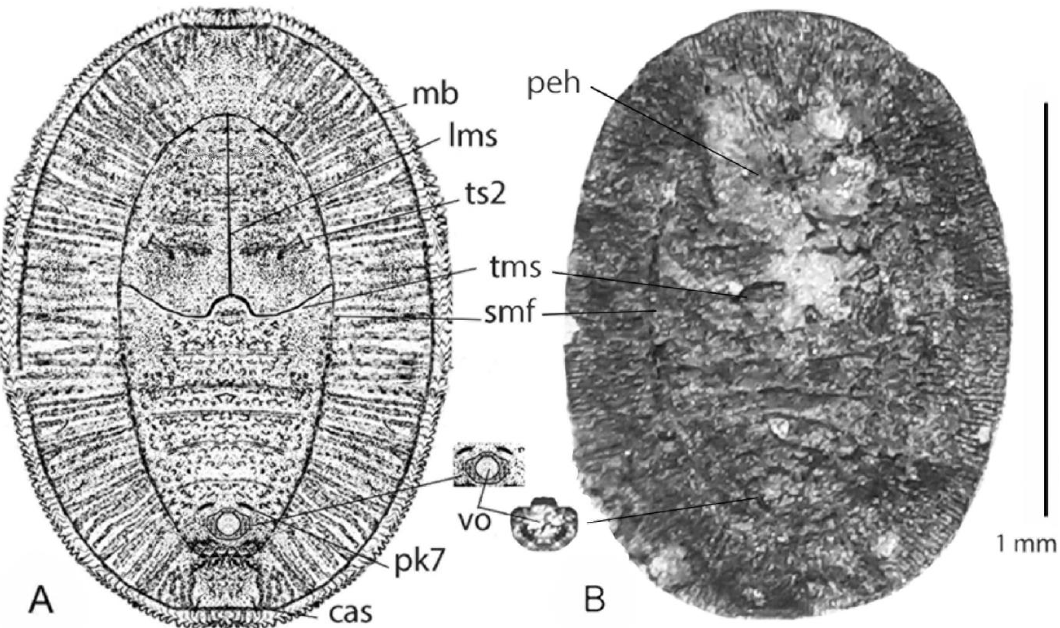
Figure 4. Puparia of Praealeurolobus indicus. ( A ) Line drawing. ( B ) Scanned image. Abbreviations used: cas (caudal setae), lms (longitudinal molting suture), mb (marginal band), peh (parasitoid emergence hole), pk7 (pockets on 7th abdominal segment), smf (submarginal furrow), tms (transverse molting suture), ts2 (mesothoracic setae), vo (vasiform orifice). Scale bar = 1 mm.